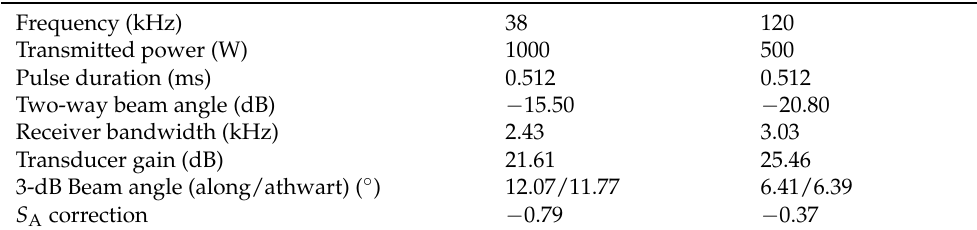
Table 2. Calibration specifics for transceivers